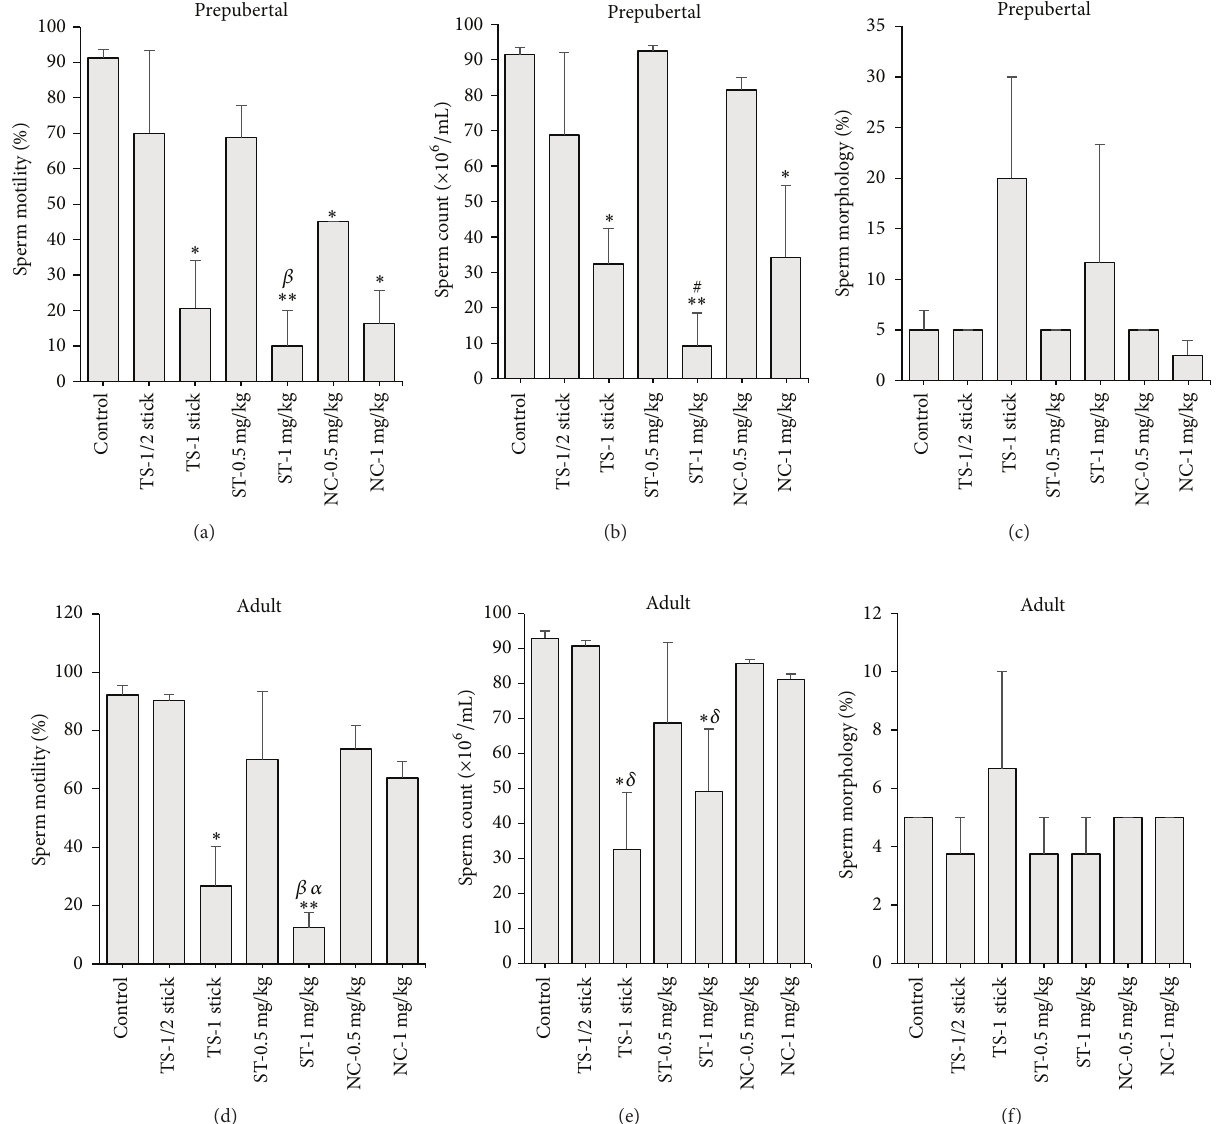
Figure 2: Effects of 30-day daily exposure to cigarette smoke (tobacco smoke, TS), smokeless tobacco (ST), and nicotine on sperm motility, count, and morphology in prepubertal ((a), (b), and (c)) and adult rats ((d), (e), and (f)). Data are expressed as mean ± SEM ( 𝑛 = 6 ). ∗ 𝑝 < 0.05 compared to control; ∗∗ 𝑝 < 0.01 compared to control; 𝛽 𝑝 < 0.05 compared to TS-1 stick; 𝛼 𝑝 < 0.01 compared to NC-1mg/kg; # 𝑝 < 0.05 compared to TS-1 stick and NC-1mg/kg; 𝛿 𝑝 < 0.05 compared to